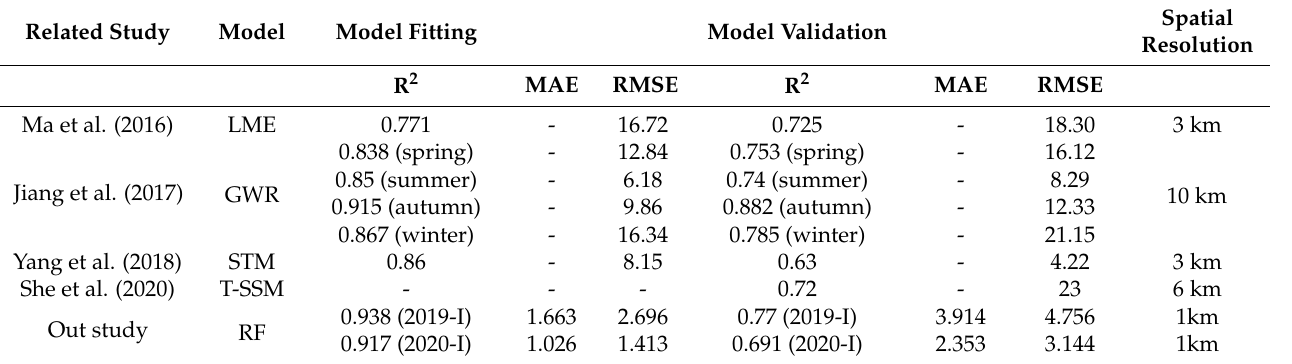
Table 4. Statistics for the comparisons in performances of different regression models in Yangtze River Delta. Related Study